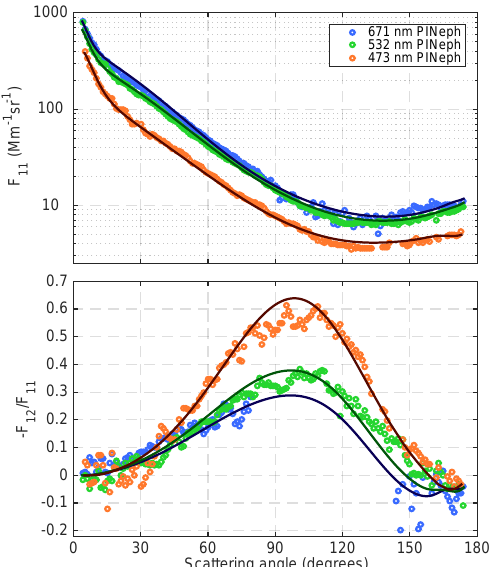
Figure 7. Scattering matrix elements at 473nm (blue), 532nm (green) and 671nm (red) measured over a forested region of south- eastern Missouri along with the corresponding GRASP fits (solid